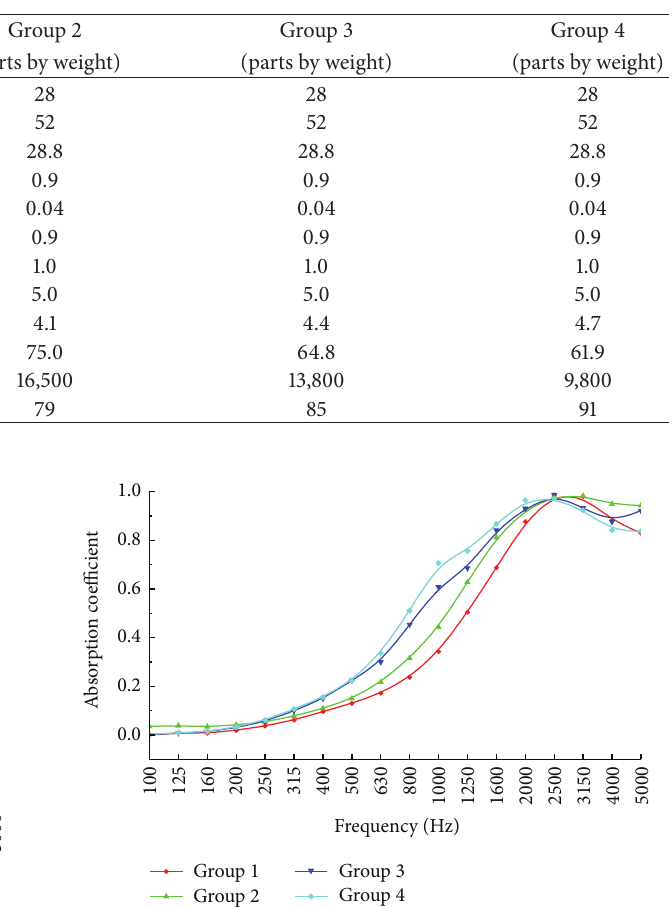
Table 4: Main components and properties of the foams.